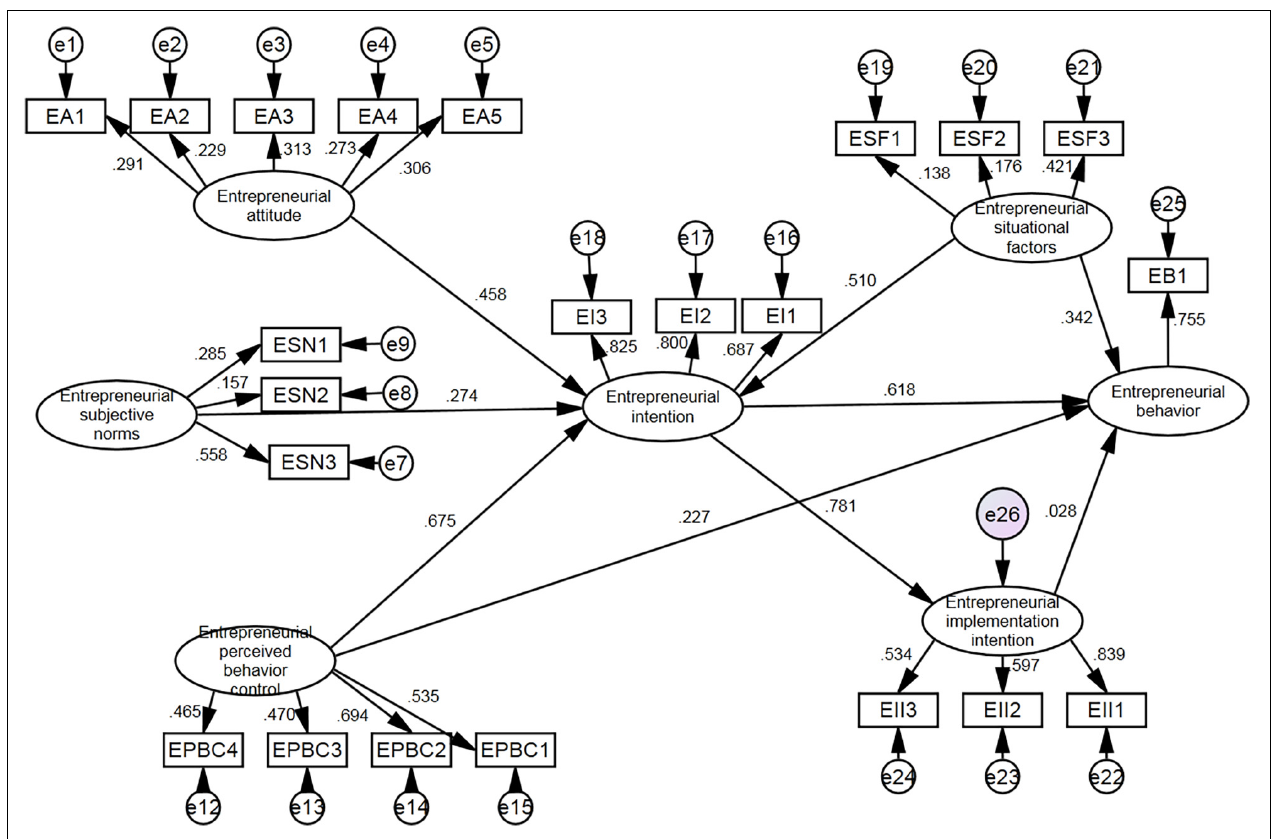
FIGURE 3 | The estimated path coefficient for the college student entrepreneurial intention-behavior extended